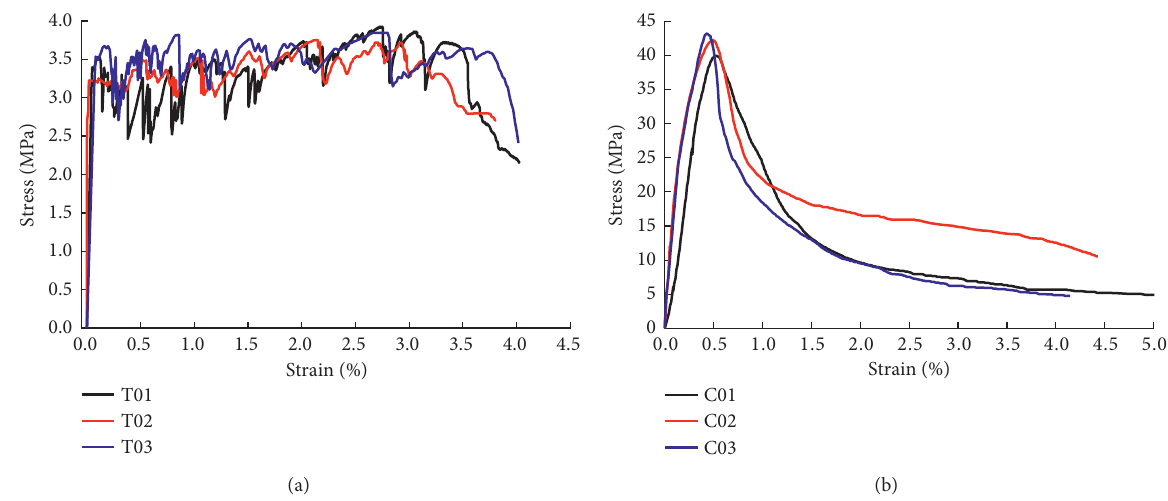
Figure 2: ECC uniaxial tensile and compression stress-strain curves. (a) Uniaxial tensile. (b) Uniaxial